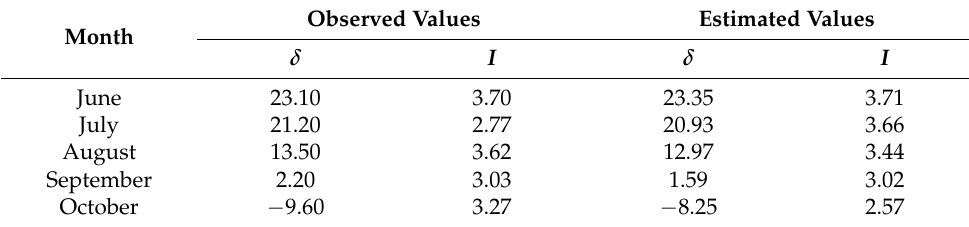
Table 4. Declination and solar radiation data.